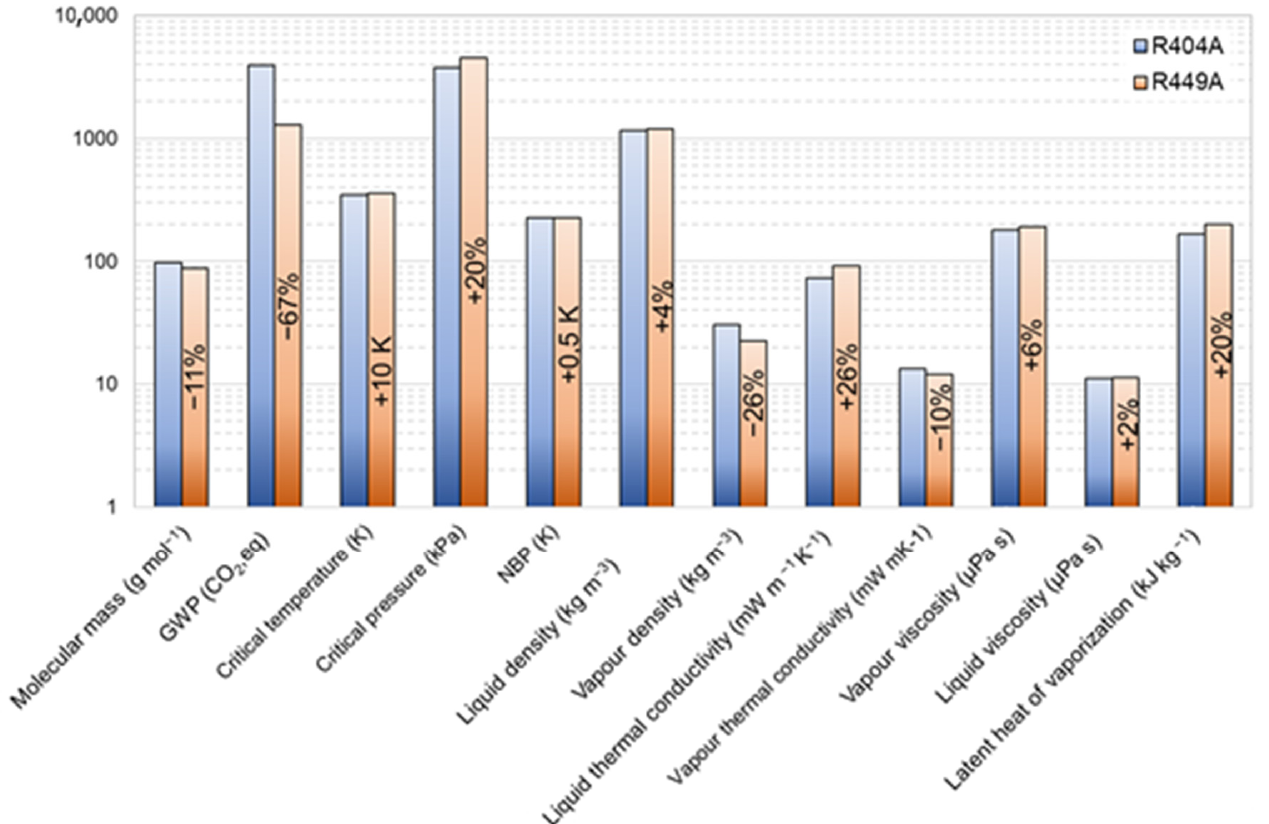
Figure 1. Comparison between the main properties of R404A and R449A.